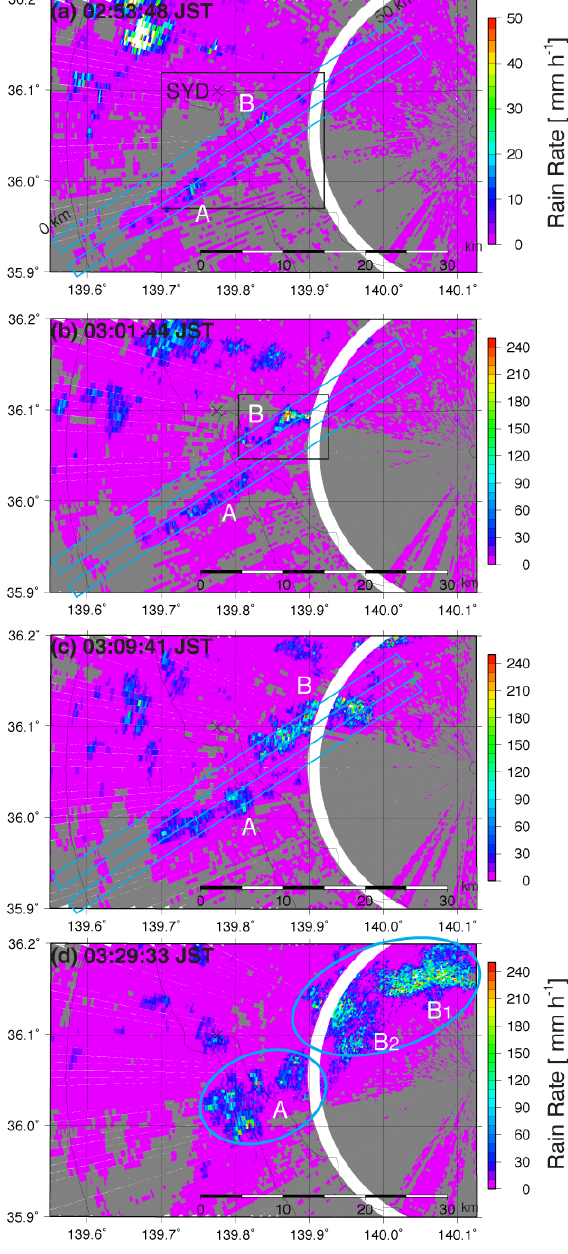
Fig. 8. MRI C-band radar rainfall rate estimation using differen- tial reflectivity R(Z H , Z DR ) observed at a 1.0 ◦ elevation angle at (a) 02:53JST, (b) 03:01JST, (c) 03:09JST, and (d) 03:29JST on 7 July 2010. The color scale represents the rainfall rate. A and B in the figure indicate convective rainfall cells. The cross symbol indi- cates the location of the Sekiyado (SYD) surface observation sta- tion. Blue rectangles representing a length of 50km indicate the distance-height analytical areas in Figs. 9 and A2, and black rectan- gles in (a) and (b) indicate the analytical area in Figs. 10 and 11, and Figs. 12–14, respectively. Ellipses in (d) surround the matured A and B ( B 1 and B 2 ).